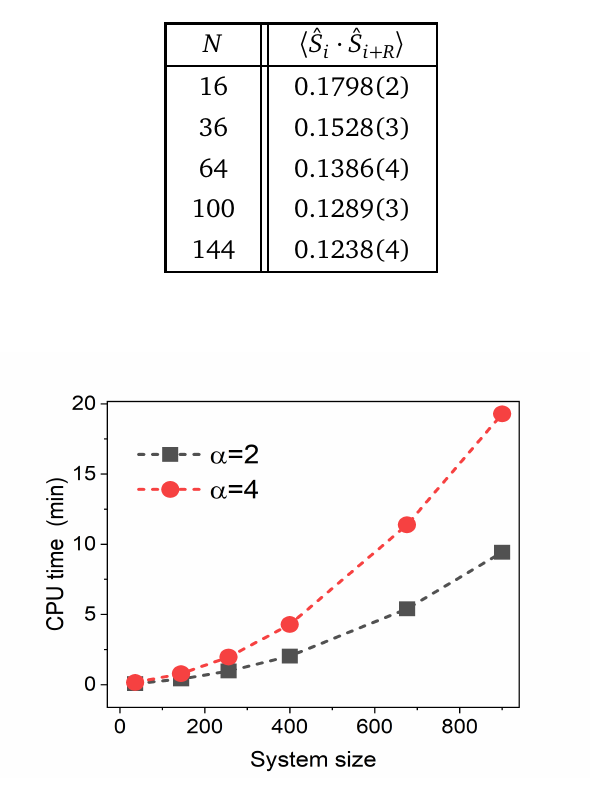
Table 2: Ground state spin correlation functions 〈 ˆ S Evaluation of the correlations is done by sampling 10 6 states. For N = 16 we used α = 10, while for larger N we used α = 16. Errors are calculated as statistical errors on the Monte Carlo sampling.